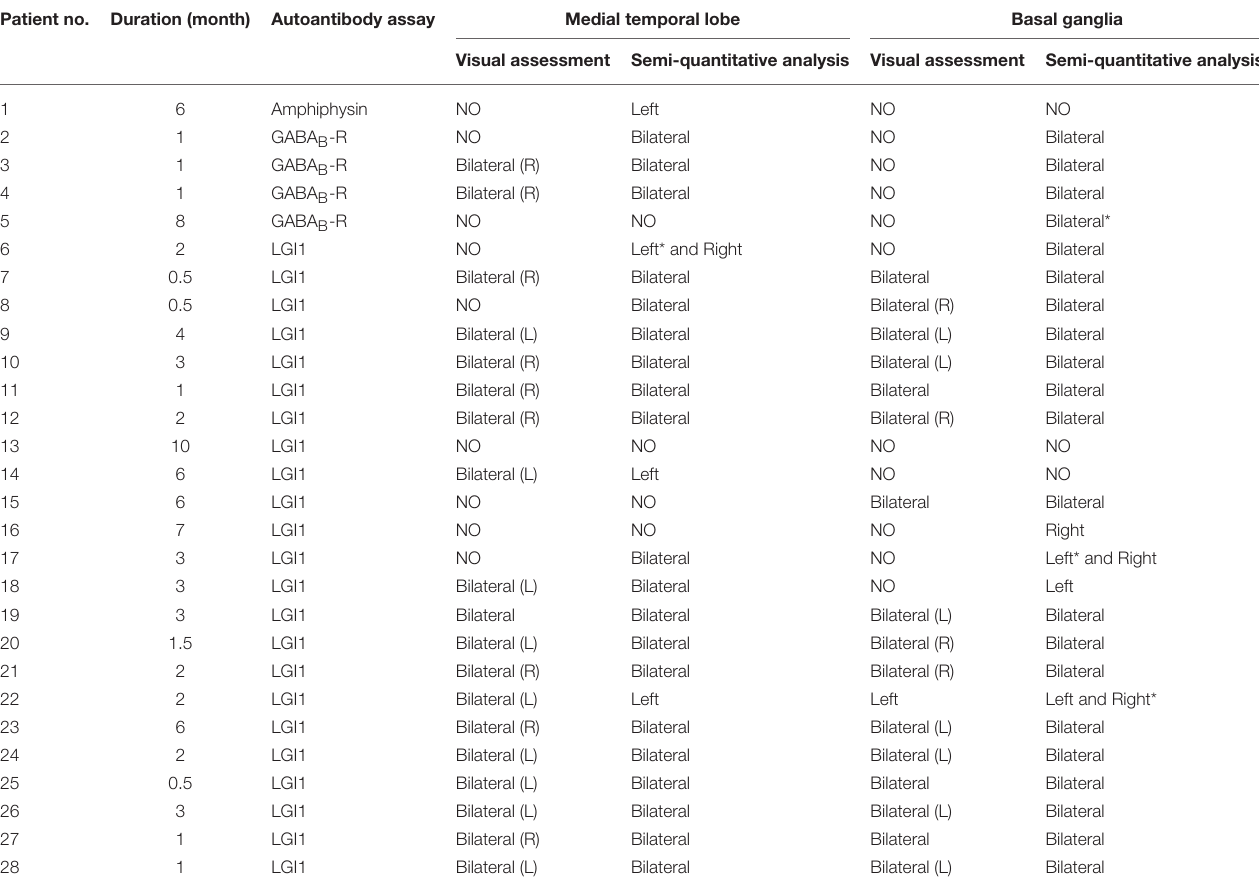
* The ROI was identified as hypometabolism. Bilateral (L/R) means that the level of hypermetabolism in left/right regions was higher than right/left